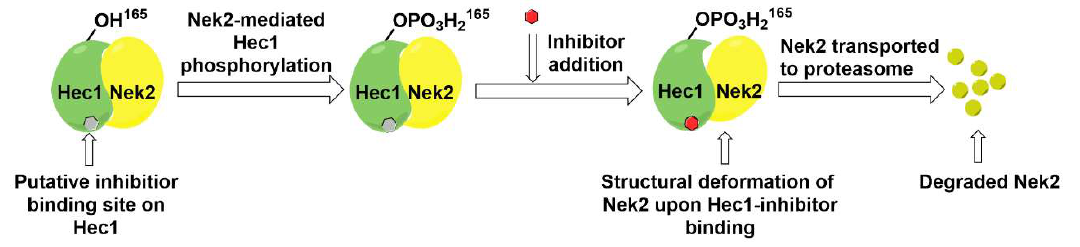
Figure 13. Schematic representation of targeting Hec1/Nek2 axis by thiazole-based inhibitors and its effect on promoting proteasomal degradation of Nek2 kinase.